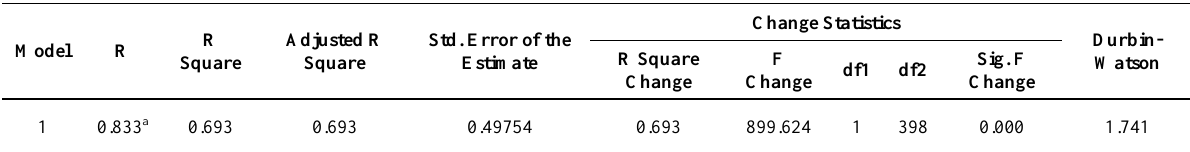
Table 5. Model Summary b